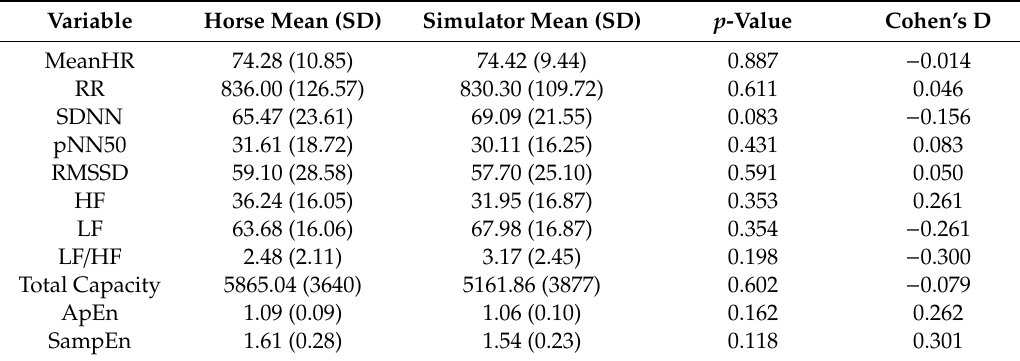
Table 2. Acute e ff ects analysis of riding a horseback or in the